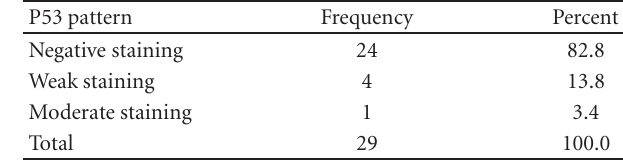
Table 3: p53 expression of nuclear staining in the nontumor duct cells.